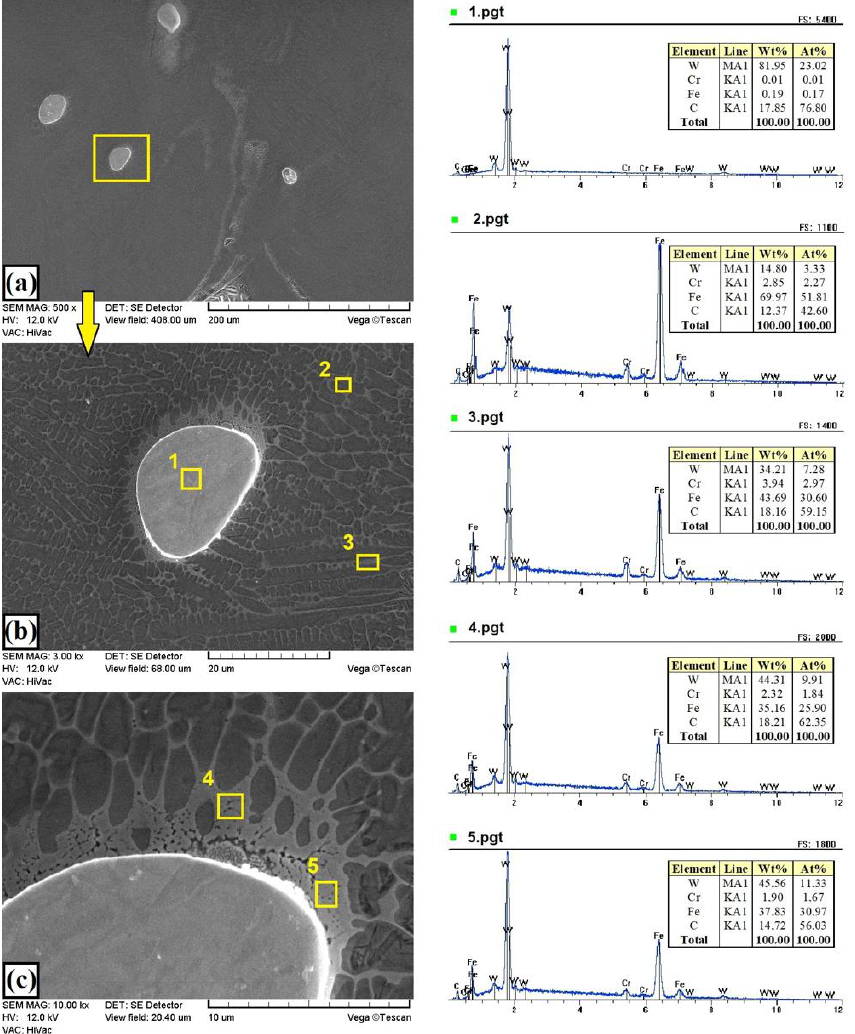
Figure 8. Microstructure and EDS point analysis of W–Cr coating reinforced with 75% WC particles produced using laser processing of precoat applied on steel substrate: ( a ) general view of the melting zone; ( b ) selected carbide; ( c ) carbide-matrix interface.